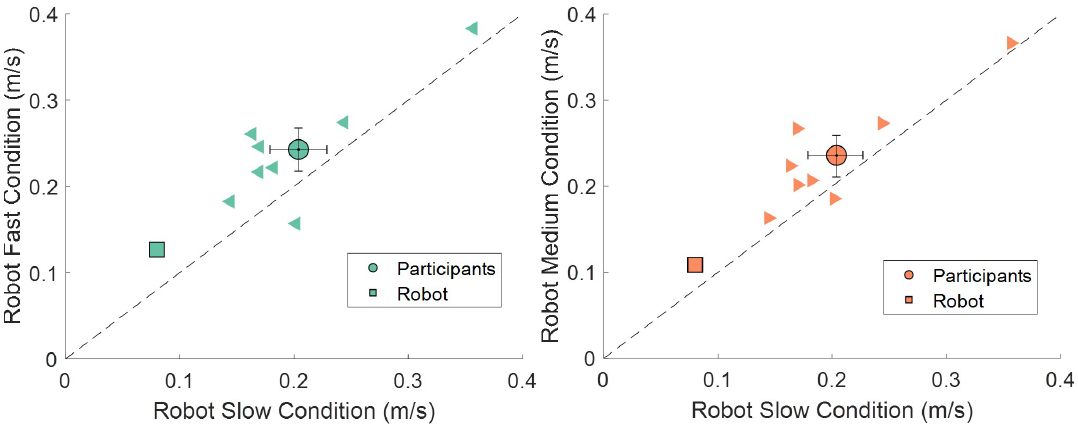
Figure 8: Individual speed of subjects in the “Robot Fast” and “Robot Mid” speed condition, in relation to their speed in the “Robot Slow” speed condition (“One Box”). Same conventions as Figure 5. (Japan)